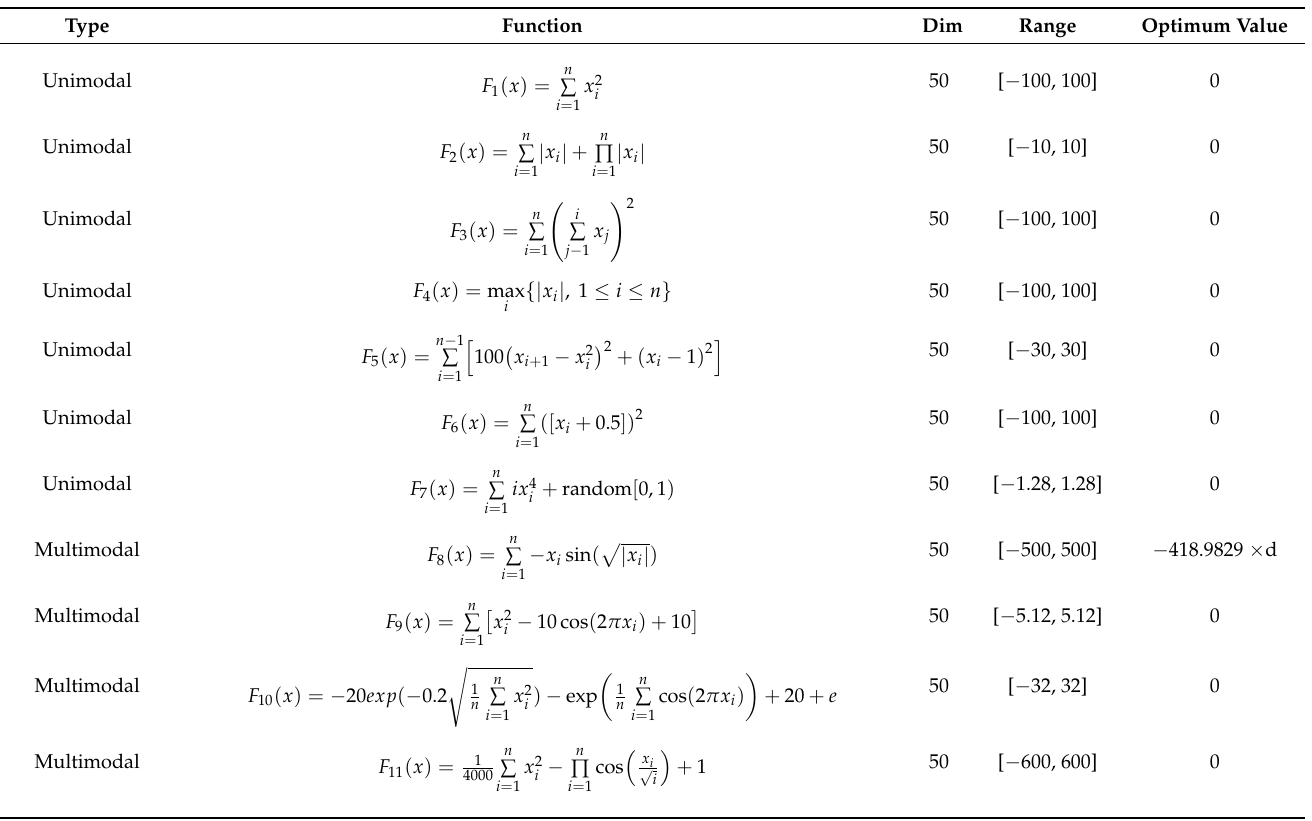
Table 2. Description of the 18 classical benchmarking